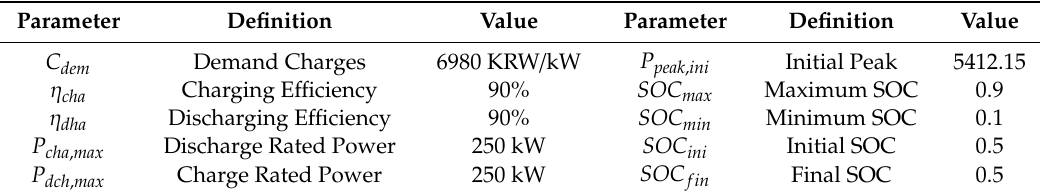
Table 2. Configuration data for the optimization model.